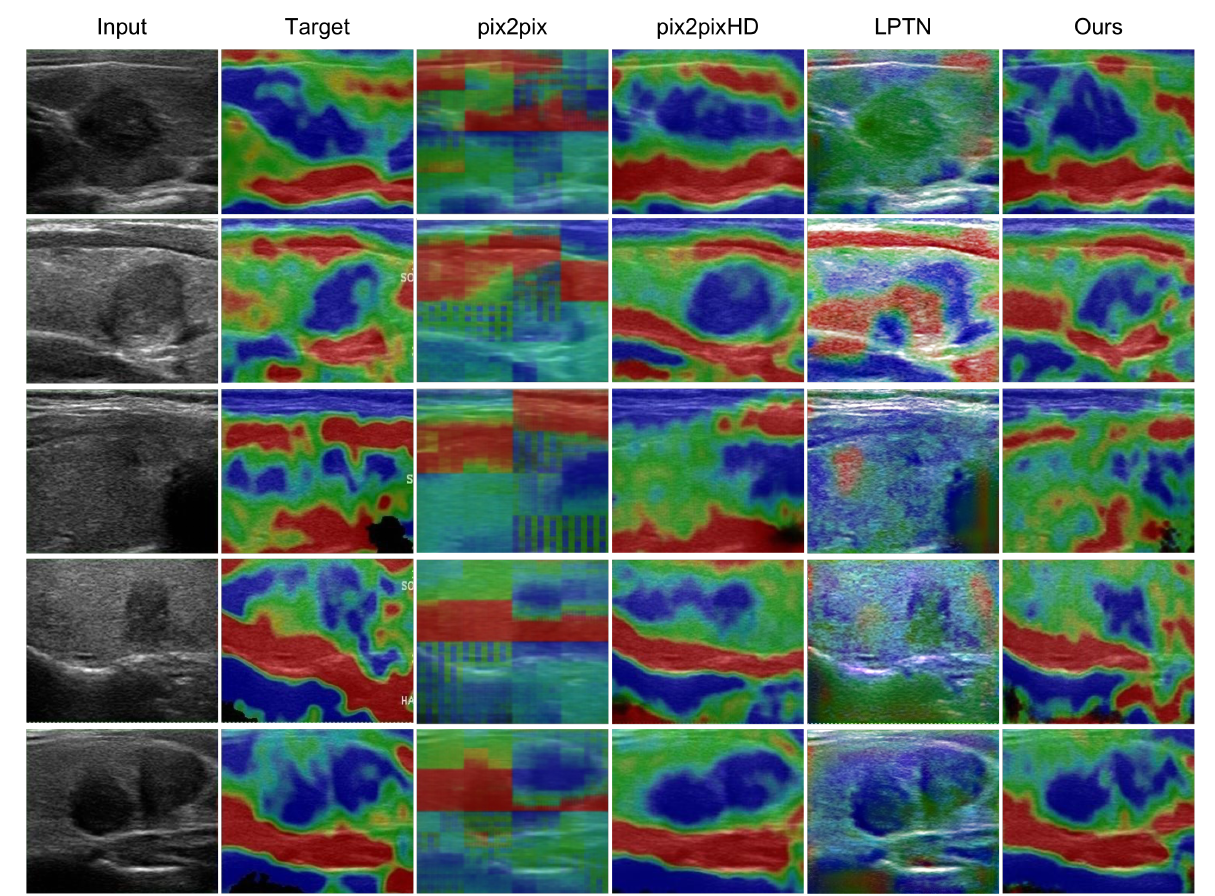
Figure 6. Generation results compared to pix2pix, pix2pixHD and LPTN. First two columns show input ultrasound data and target elastography image.